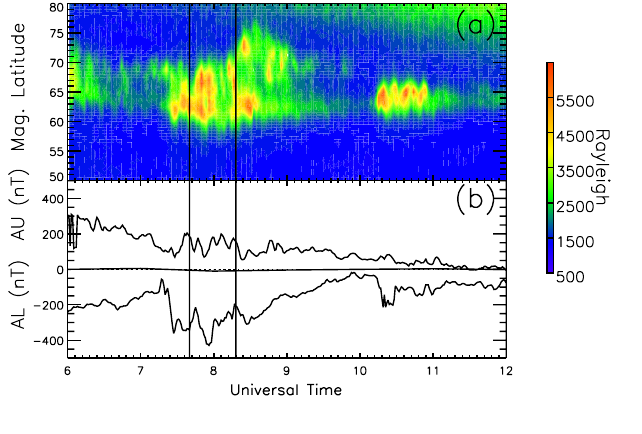
Fig. 6. (a) Keogram of auroral intensity along the 00:00MLT meridian between 50° and 80° magnetic latitude from 06:00 to 12:00UT. (b) The AU and AL auroral indices between 06:00 and 12:00UT. The vertical lines indicate substorm onsets.